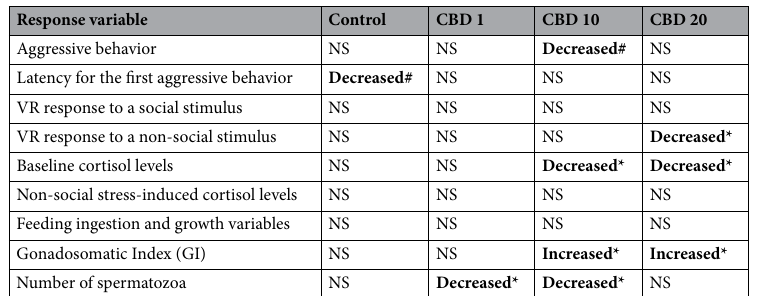
Table 1. Short table summarizing the results found in this study. CBD cannabidiol, VR ventilation rate. ‘NS’ indicates no significant effect of the group in the indicated response variable (Tukey HSD test, p > 0.05). ‘#’ indicates significant differences between the group and the baseline measurement of the same treatment (Tukey HSD test, p < 0.05). ‘*’ indicates significant differences between the group and the control (Tukey HSD test, p <